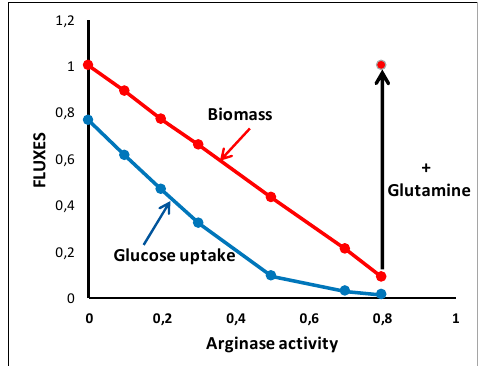
Figure 9. Arginine deprivation. Arginine deprivation is obtained with increased expression of Arginase in the situation of Figure 8b with the same input of glutamine (0.883). An increase in glutamine input (1.683) restores the biomass to 1.